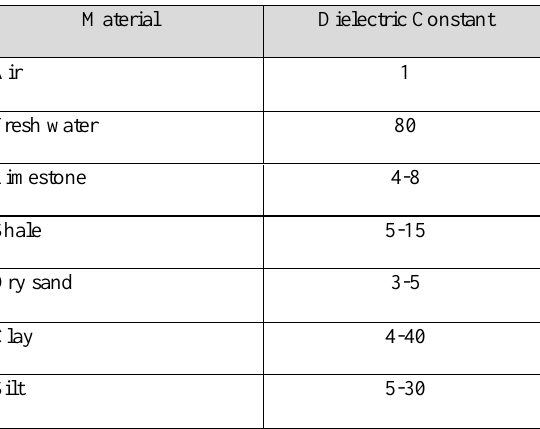
Table 3 . Dielectric constant through various media (Davis and Annan,